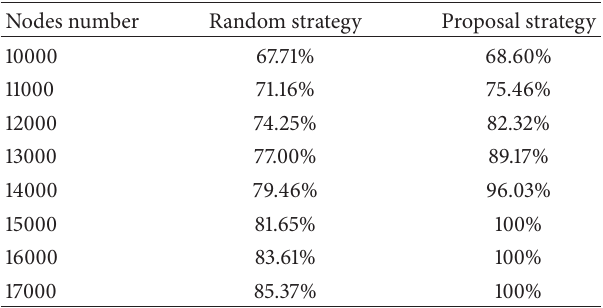
Table1:Theinfluenceofinitialnodesnumberonthescenecoverage